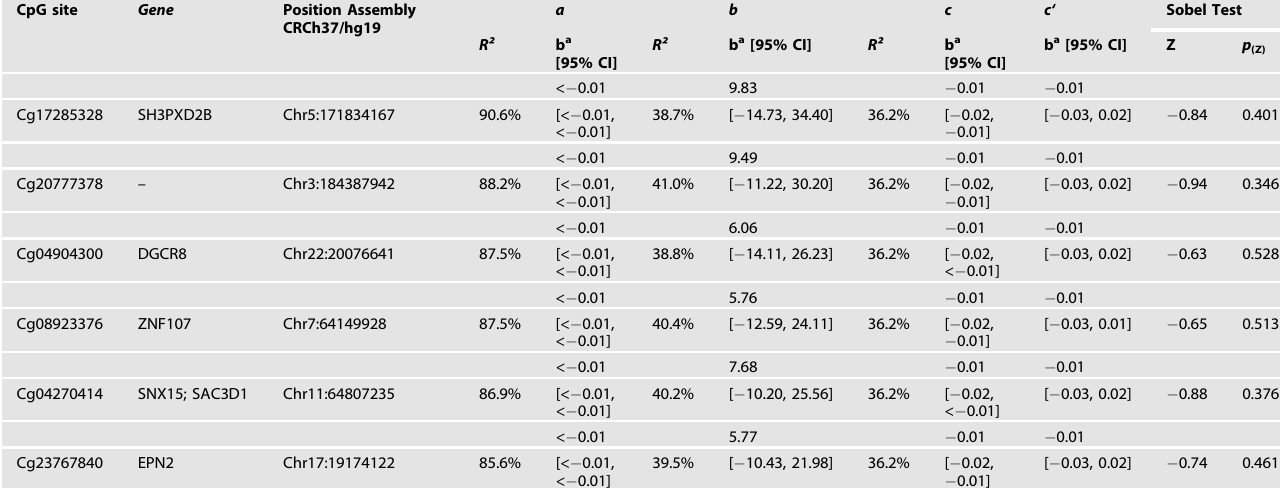
Table 6. Mediating effects of CpG methylation for association between self-reported cannabis use and VLMT cued recall trial. CpG site